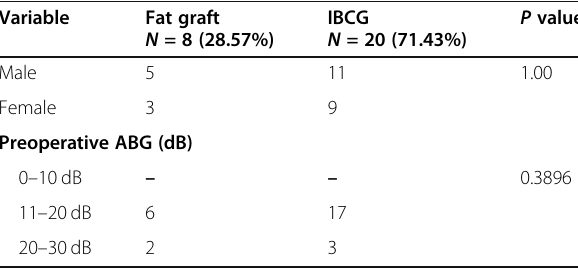
Table 1 Preoperative demographic and audiological data Variable Fat graft N = 8 (28.57%)